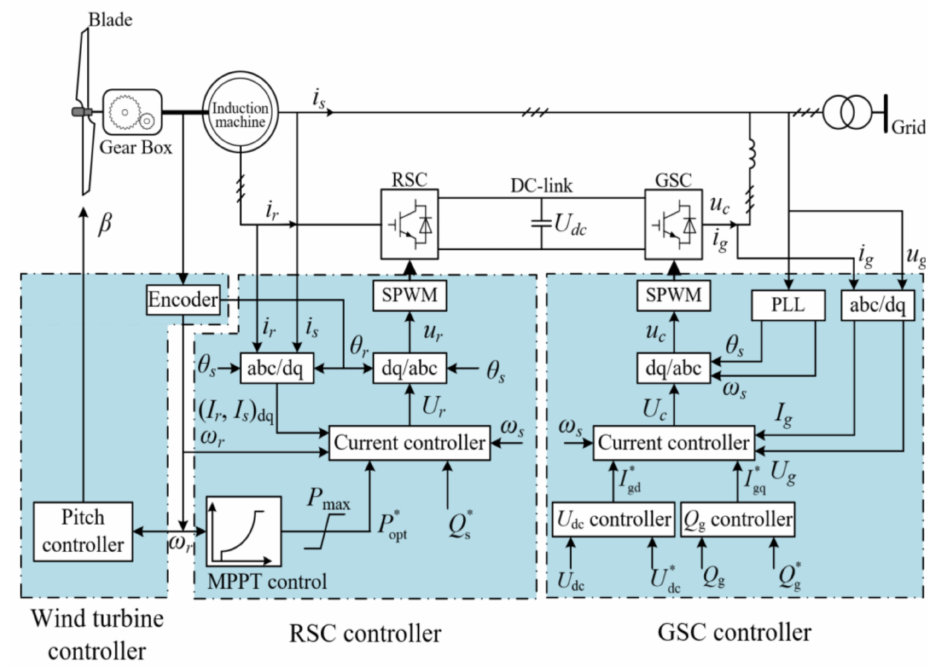
Figure 1. Typical structure of a DFIG and its